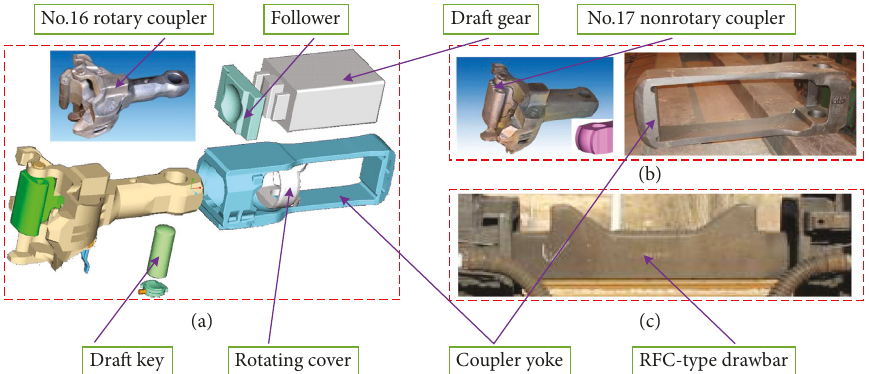
Figure 3: The structure diagram of coupling devices and draft gear system: (a) no.16 rotary coupler; (b) no.17 non-rotary coupler; (c) RFC- type drawbar.